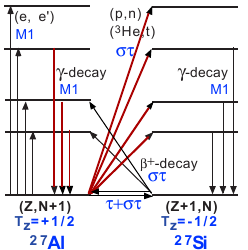
Figure 1. Schematic level schemes are shown for T = 1 / 2, odd- A mirror nuclei. Analogous transitions connecting the ground states in the mirror nuclei with excited states in the same nucleus and the conjugate nucleus are indicated. The type of reaction or decay and the relevant interactions causing each transition are shown along the arrows indicating the transitions.